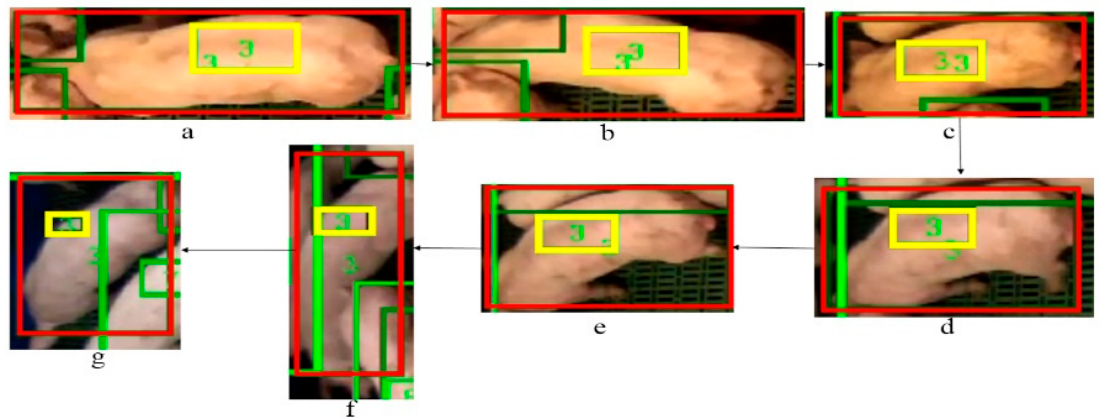
Figure 6. The example results of our method to tackle the shape deformations. The final detected and tracked bounding boxes are shown in red colour, the tag ‐ boxes are shown in yellow, and the unique ID numbers for tracked detection boxes and tag ‐ boxes are shown in green. The sequence order is from frame ( a ) to ( g ). ID 3 is correctly kept with correct detection bounding boxes.